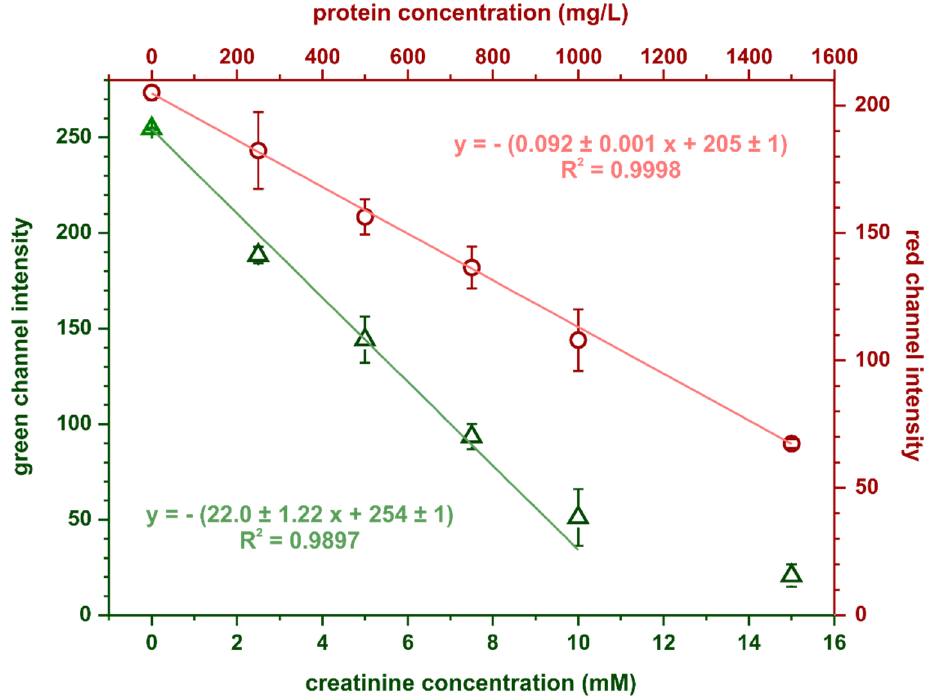
Figure 5. Calibration dependencies obtained in the optimal conditions for simultaneous protein and creatinine determination, n =